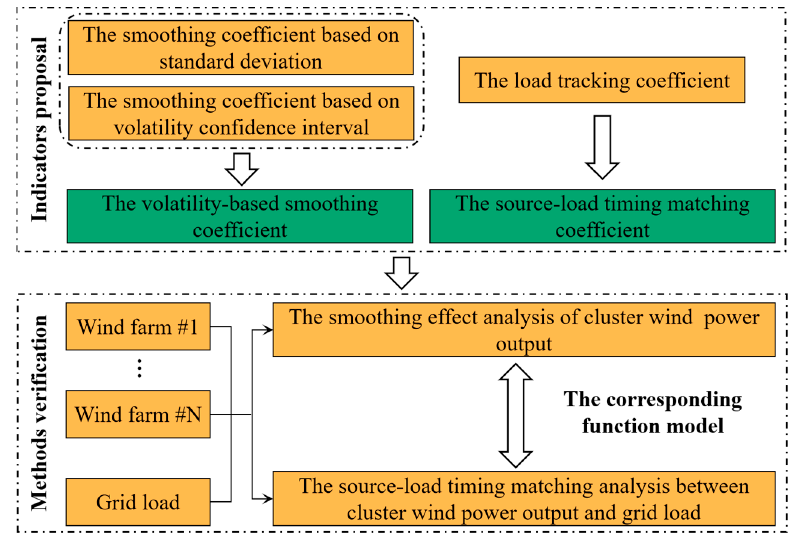
Figure 1. The basic idea of this paper.